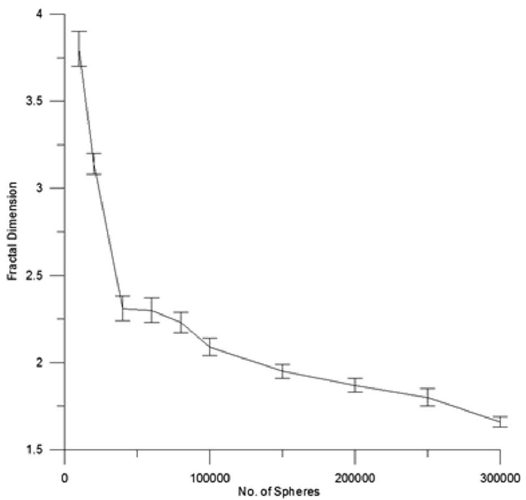
Fig. 2a. Gravity data over a portion of South Africa. The grid spac- ing is 1km.